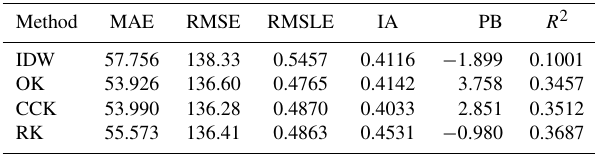
Table 5. Moving-window cross-validation results. Table 6. Summary of indoor radon predictions (AM, ground